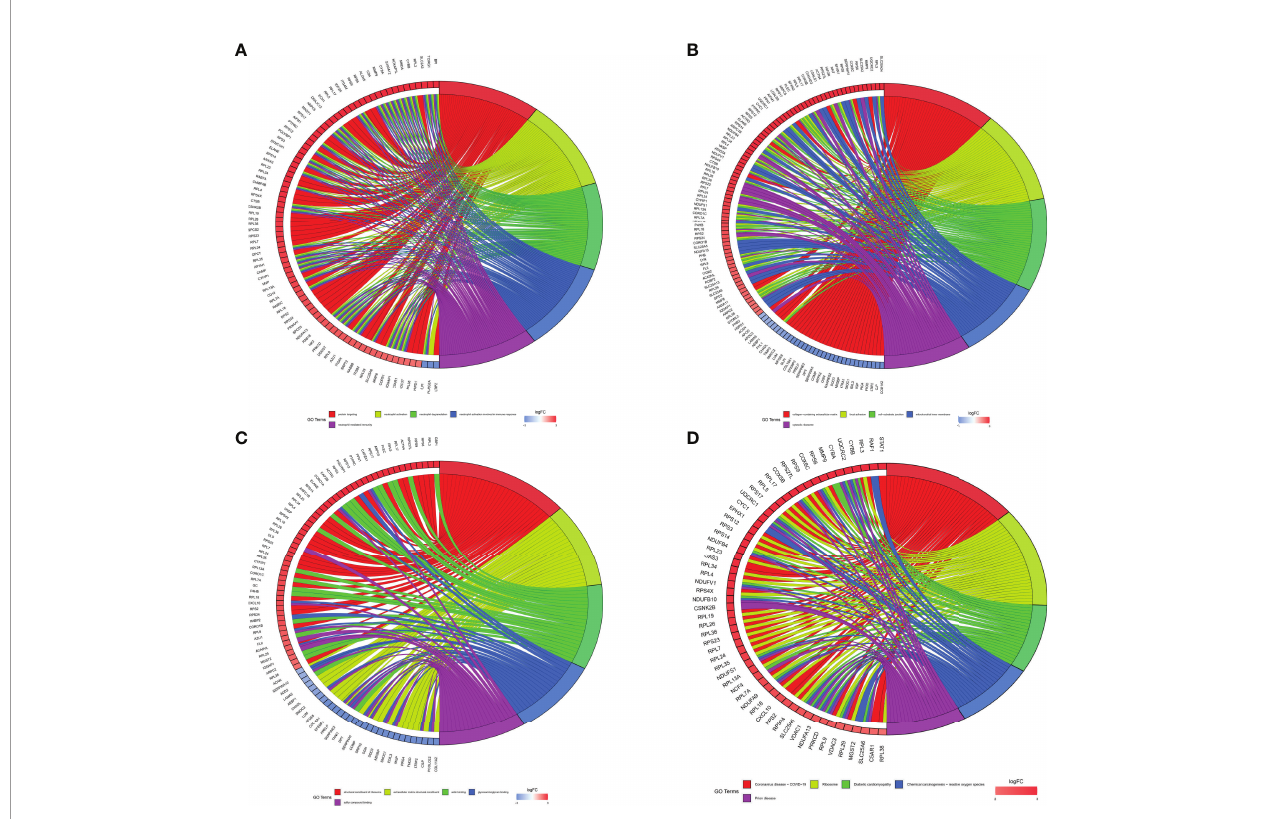
FIGURE 7 | GO and KEGG pathway enrichment analyses were plotted. (A) BP functional enrichment had 284 entries. The 5 entries with the most enriched protein counts were plotted. (B) CC functional enrichment had 284 entries. The 5 entries with the most enriched protein counts were plotted. (C) MF functional enrichment had 284 entries. The 5 entries with the most enriched protein counts were plotted. (D) KEGG pathway enrichment had 284 entries. The 5 entries with the most enriched protein counts were plotted.